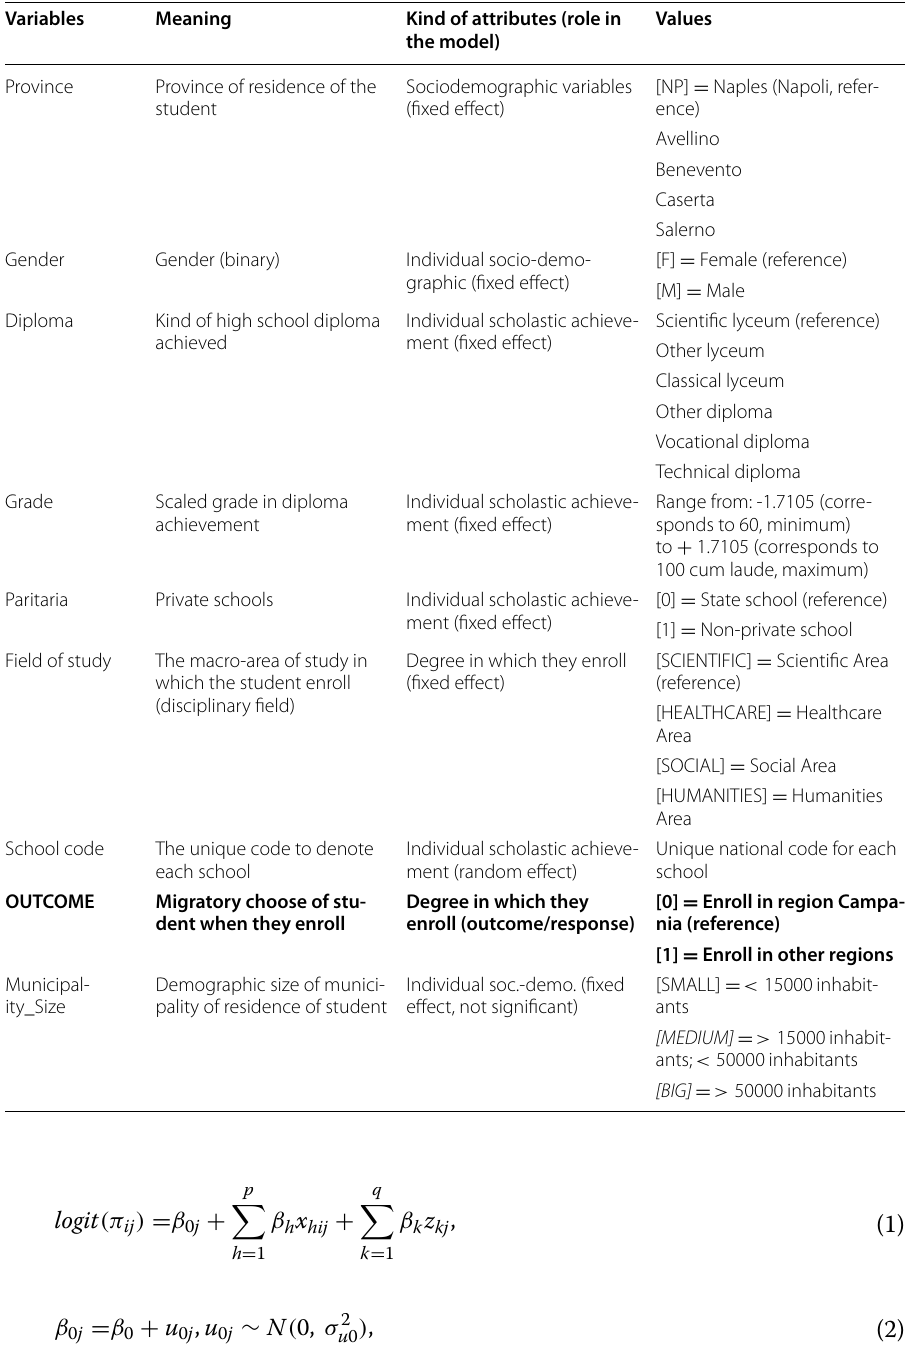
Table 4 Variables of the models